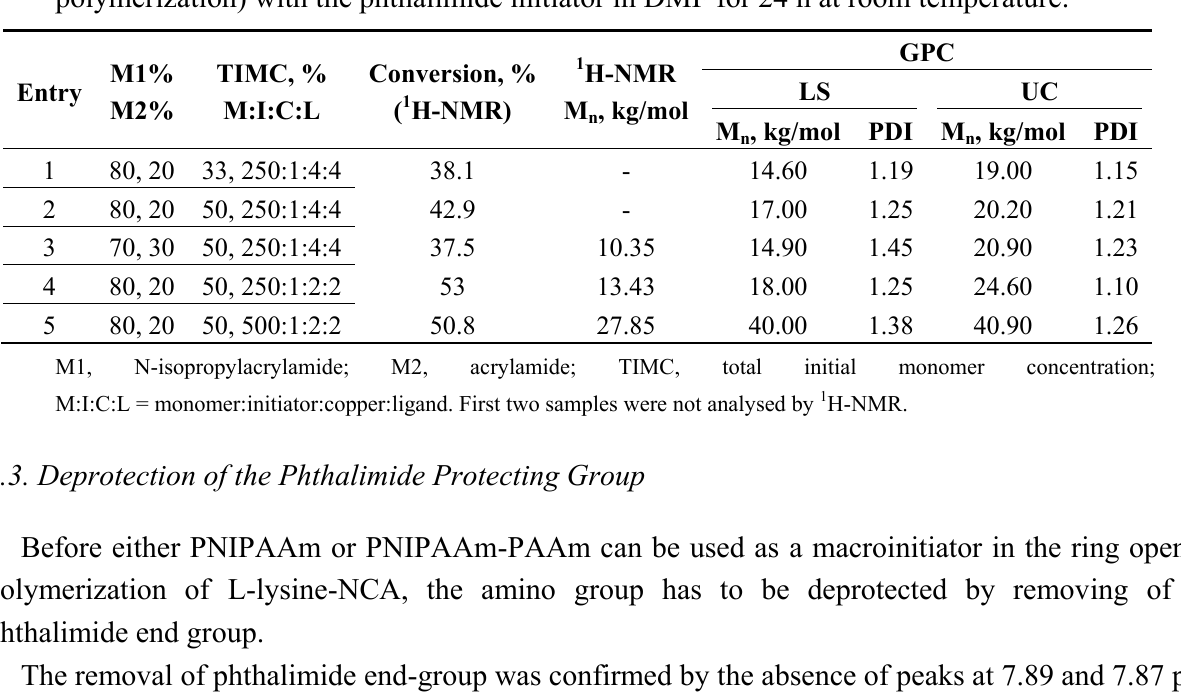
Table 2. Random copolymers of NIPAAm and AAm prepared by ATRP (atom transfer radical polymerization) with the phthalimide initiator in DMF for 24 h at room temperature.